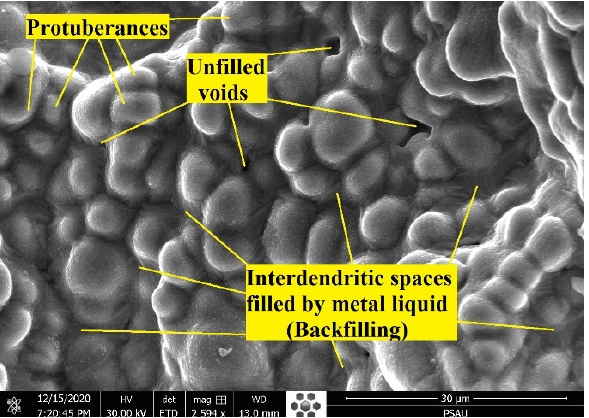
Figure 15. SEM micrograph at the solidification cracking surface in TIG weld coated with the mixture of powders (80% Nb + 20% Ti) × 2500.